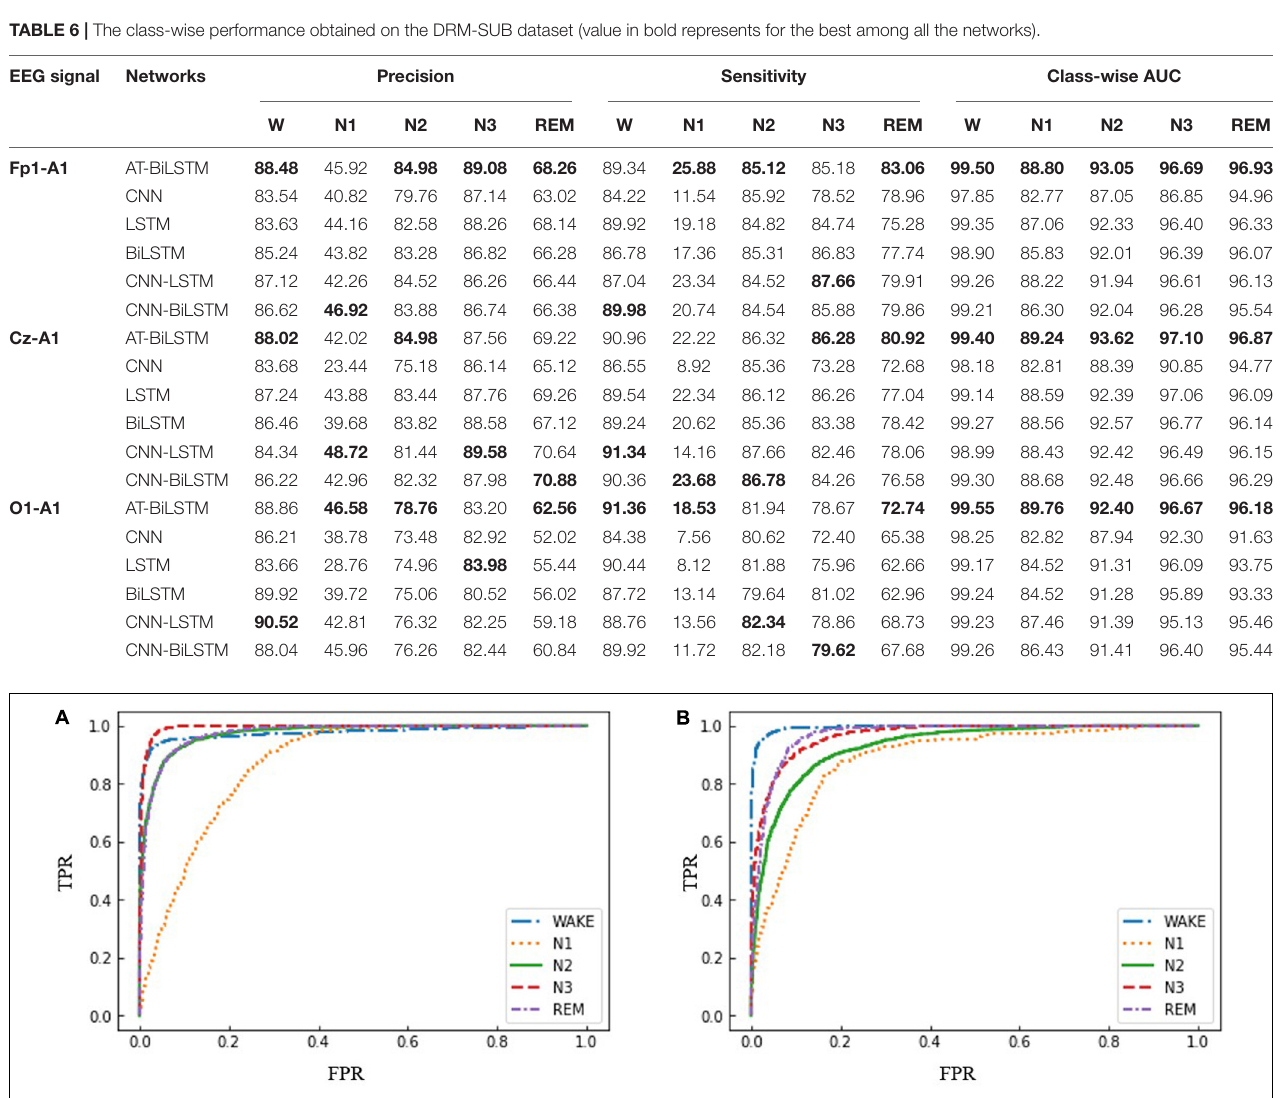
FIGURE 5 | ROC curves for sleep stages using the proposed AT-BiLSTM models trained with (A) Fpz-Cz channel of PSEE dataset and (B) Fp1-A1 channel of DRM-SUB dataset.